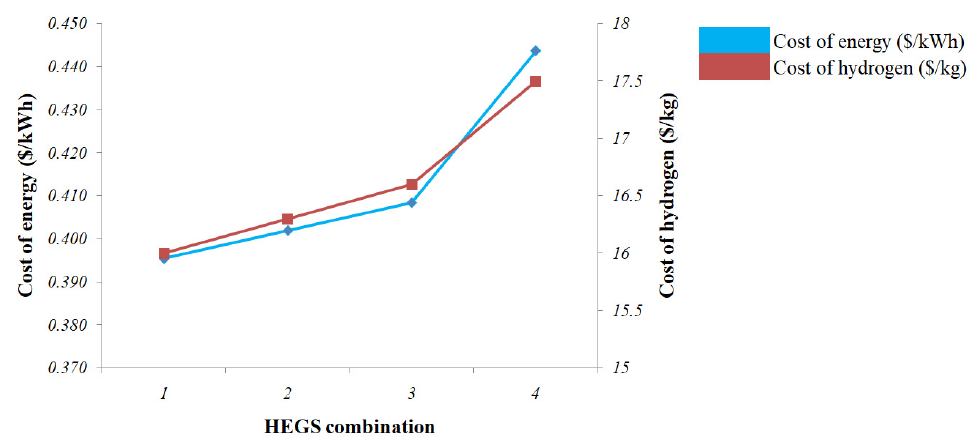
Figure 12. Comparison of total system cost for selected HEGS combination.